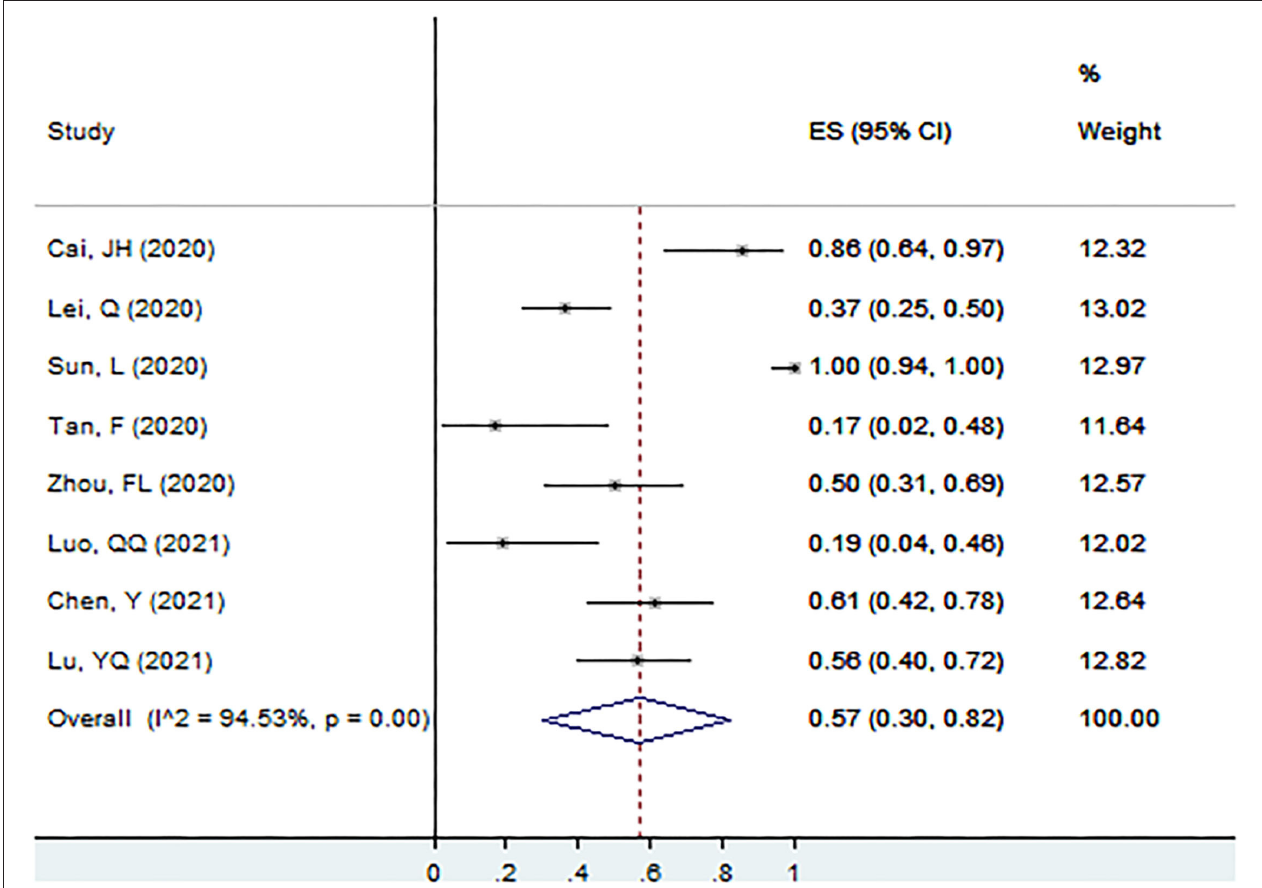
FIGURE 5 | The proportion of Ig M + in patients with asymptomatic infection at the screening